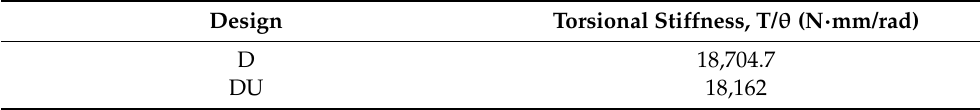
Table 6. Torsional stiffness values of D and DU